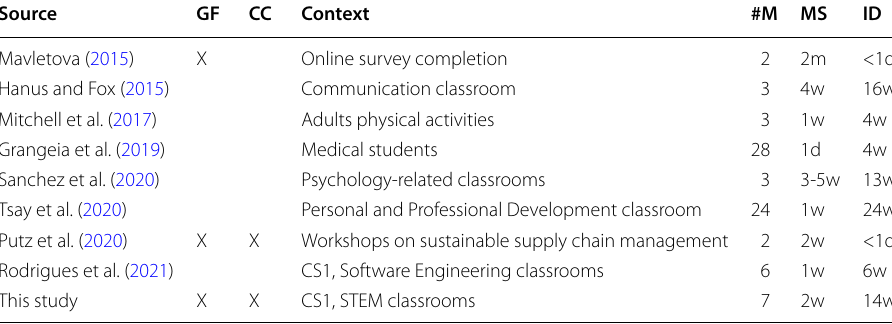
Table 1 Summary of related works and this